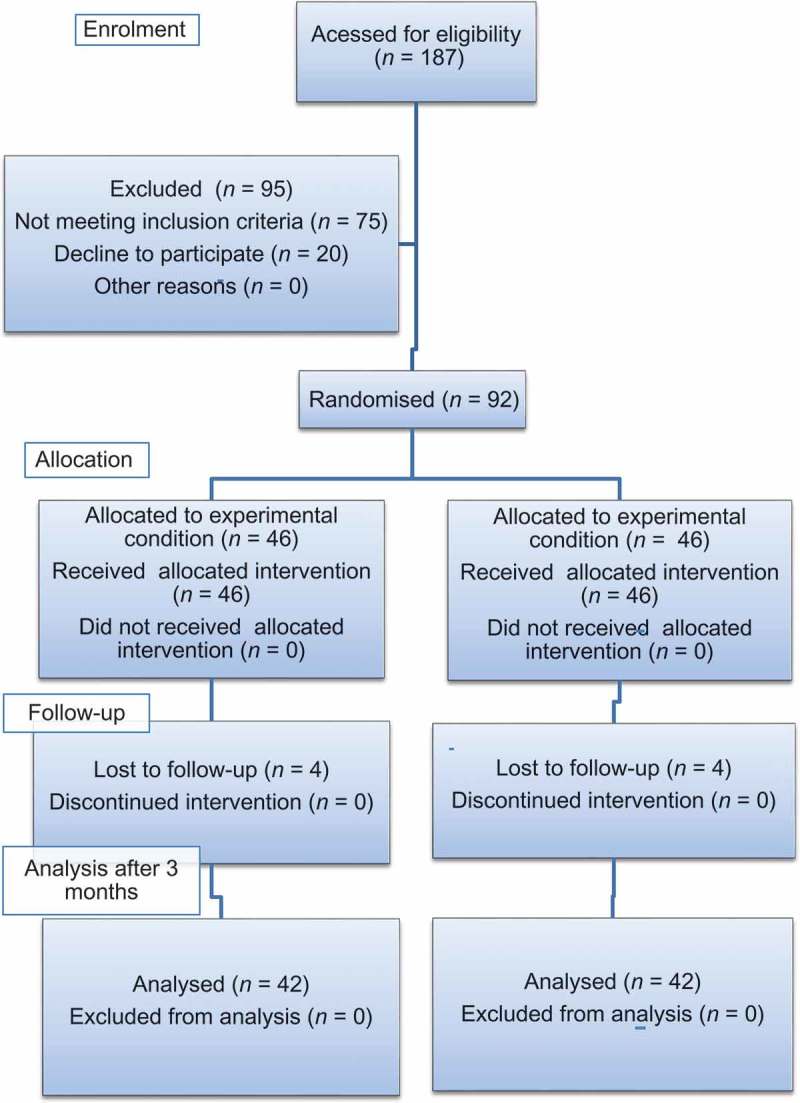
CONSORT flow chart of the study.